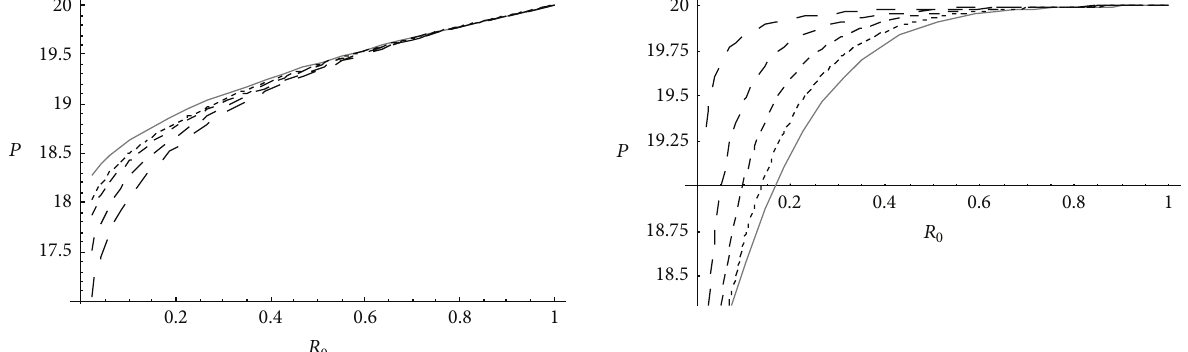
Figure 2: External or internal pressure required for initial yielding for homogeneous and nonhomogeneous circular cylinder (internal or external = 20) for different compressibility parameters.